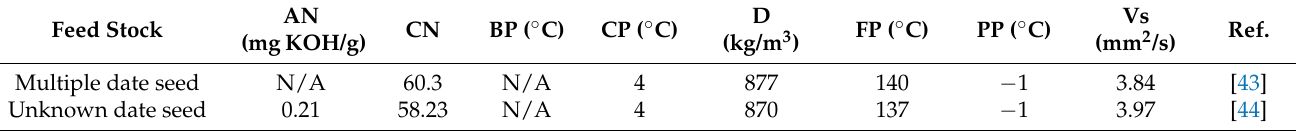
Table 1. The Characteristics of biodiesel obtained from date seed oil from previous studies. Feed